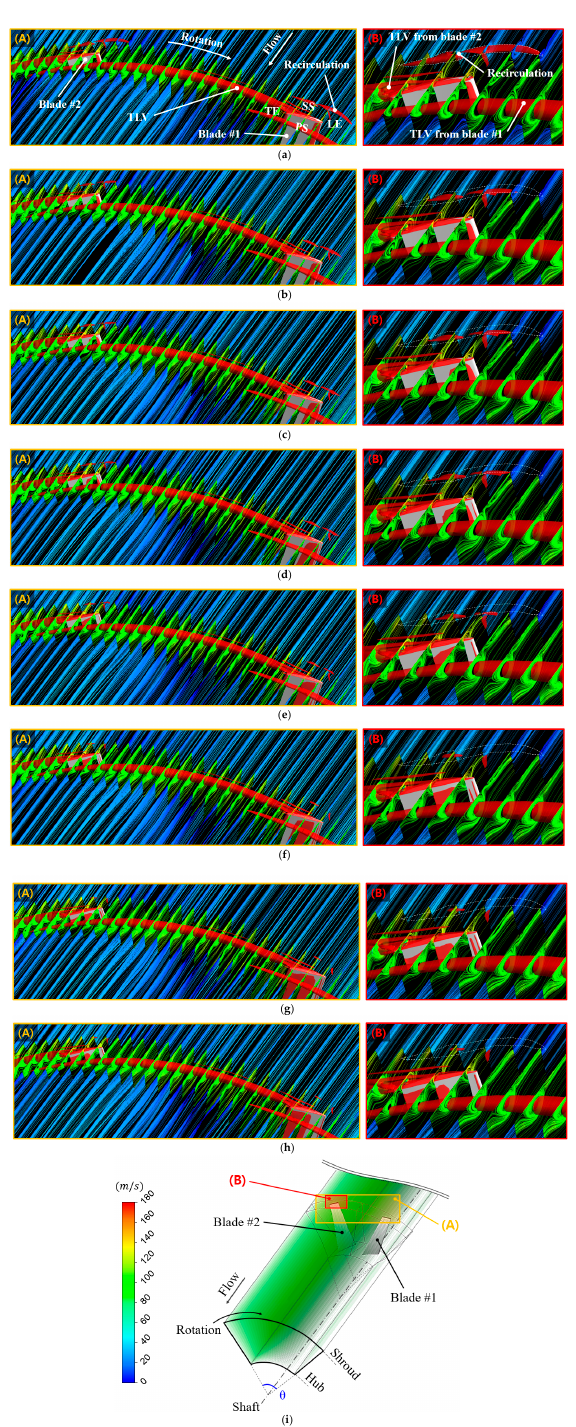
Figure 14. Internal flow characteristics with streamlines and Q -criterion on ( i ) the observation planes for the ( a ) 15%, ( b ) 20%, ( c ) 25%, ( d ) 30%, ( e ) 35%, ( f ) 40%, ( g ), 45%, and ( h ) 50% sets ( 𝛷/𝛷 (cid:3031)(cid:3032)(cid:3046) =1.0 ). The trajectory of the TLF is further specified in Figure 15. The x - and y -axis of the graph are defined in Figure 16. The x -axis is the blade chord fraction ( 𝜆 ) with normalized values of 0 and 1 for the blade LE and TE at the hub span, respectively. The y -axis is a nondimensionalized axial distance as a function of the diameter of the axial fan. Each blade was drawn by the black curve following the camber (mean) line of the shroud span. The trajectory of the TLF was extracted from the center point of the vortex core, and converted to the actual length reflecting the circumferential length. It can be seen that the TLF from blade number 1 flowed to the PS of blade number 2. The life of the TLF could be classified into (A) inception, (B) transition, (C) stabilization, and (D) deformation, as indicated by the dotted black segments on the graph. Each segment was enlarged with the ignored scale ratio at the top of the graph. In (A), the TLF was developed and detached from the blade SS. It can be seen that a smaller percentage of the maximum thickness position led to faster detachment. In (B), the TLF away from the blade flowed with an unstable pattern with respect to the maximum thickness position. In (C), the TLF began to take a stable pattern with respect to the maximum thickness position. As the percentage of the maximum thickness position decreased, the trajectory of the TLF moved upstream. In (D), the trajectories were bent while maintaining the axial pattern of (C). This could be seen as the effect of blade number 2. An important conclusion from Figure 15 is that the trajectory of the TLF with respect to the maximum thickness position showed an axial pattern. In